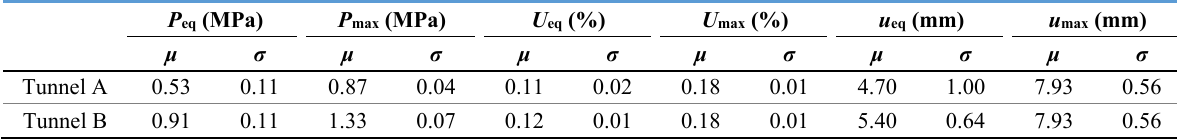
Table 8. Statistical design parameters for the shotcrete